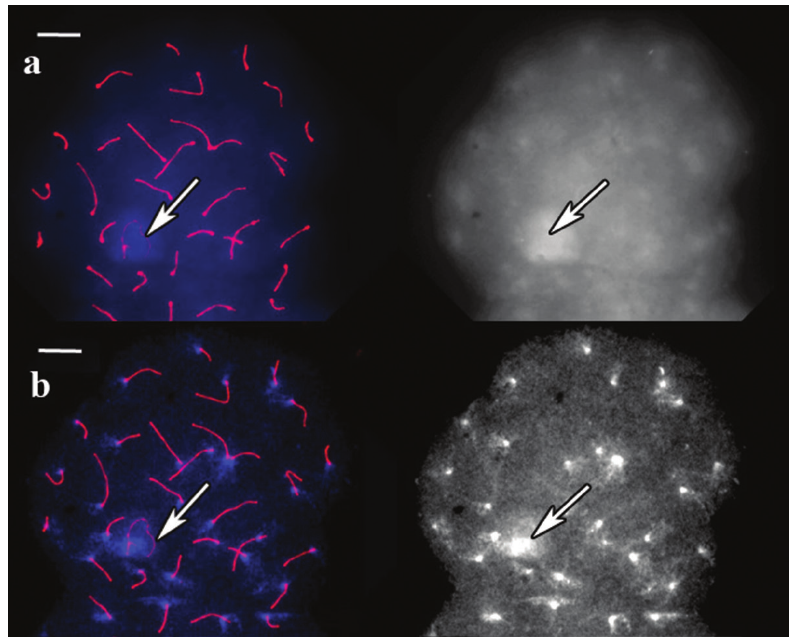
Figure 1. SC spread in red-backed vole. a A cell after immunostaining, prior to barium hydroxide treat- ment . Left: Red shows SCs (long lines) and centromeres (dots), blue represents DAPI. Right: the same image, DAPI channel separately b The same cell after 5 min of barium hydroxide treatment. Left: Red shows to SCs (long lines) and centromeres (dots), blue represents DAPI. Right: the same image, DAPI channel separately. Arrows indicate sex bivalent. Scale bars = 20